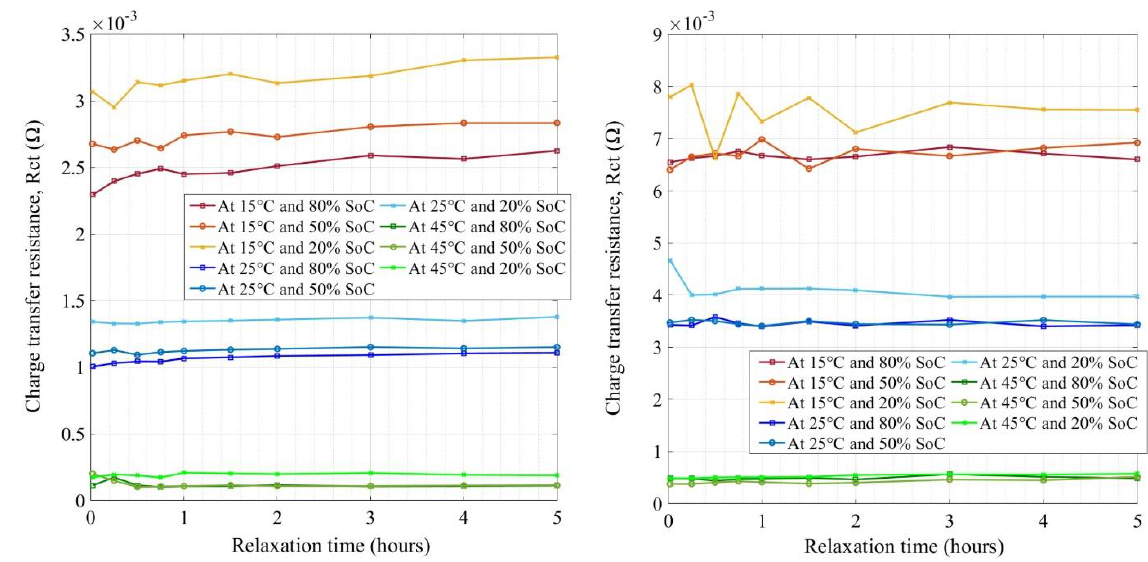
Figure 8. The charge transfer resistances for new ( left ) and aged ( right ) NMC cells. Finally, the impedance curves for new and aged NMC cells at different temperatures and SoCs after 2 h of relaxation are shown in Figure 9 (note the scales). From this com- parison, one can observe that the two semicircles in aged cells converged to one at 20% SoC with an increase in temperature. One other key aspect is how the values or semicircles came closer together at high temperatures and moved away at lower temperatures which may refer to the higher and clearer impedance values at 15 °C.